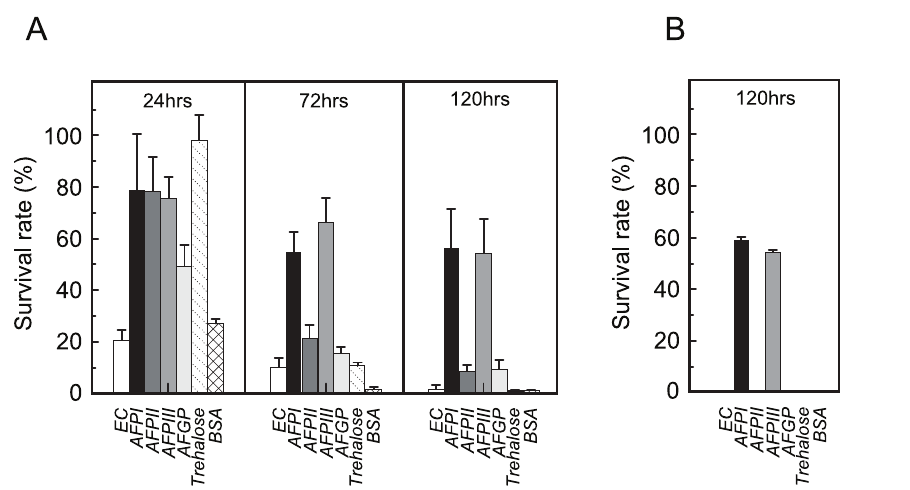
Figure 3. Time-dependent change in the survival rate (%) of rat insulinoma cell-line, RIN-5F, under hypothermic exposure ( + 4 u C). A. The survival rate evaluated by counting the number of living cells (Fig. 1B). B. The survival rate evaluated by measuring the amount of insulin secreted from living cells (Fig. 1C). A freshly made Euro-Collins solution (EC) was used as a basic cell-preservation fluid to dissolve AFPI–III, trehalose, and BSA.